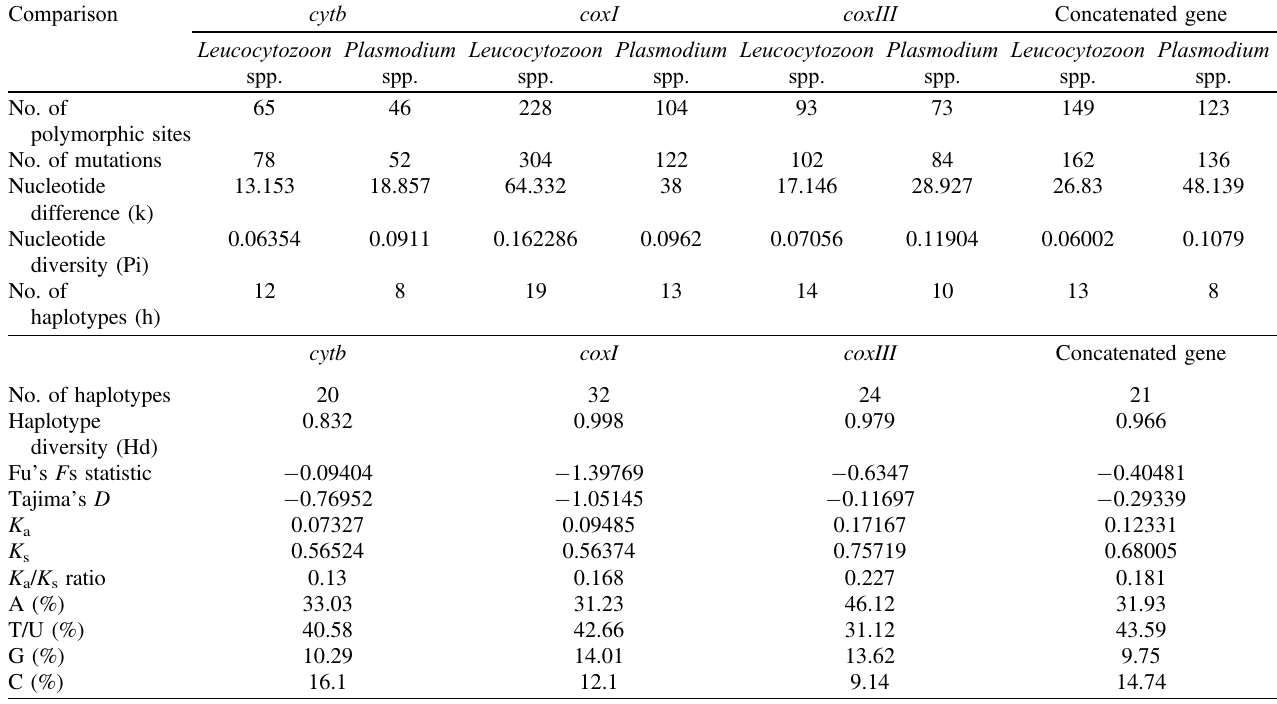
Table 2. Comparison of nucleotide sequence analyses of three mitochondrial and concatenated genes of Leucocytozoon spp . and Plasmodium spp. as detected in chicken samples in Thailand and other countries.